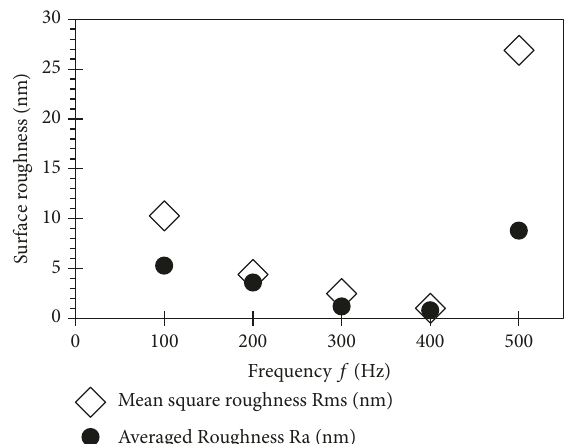
Figure 13: Surface roughness 𝑅 ms and 𝑅 𝑎 of sputtered AlTiN coatings at various pulse-frequency in the range of 100–500Hz determined via AFM measurements.